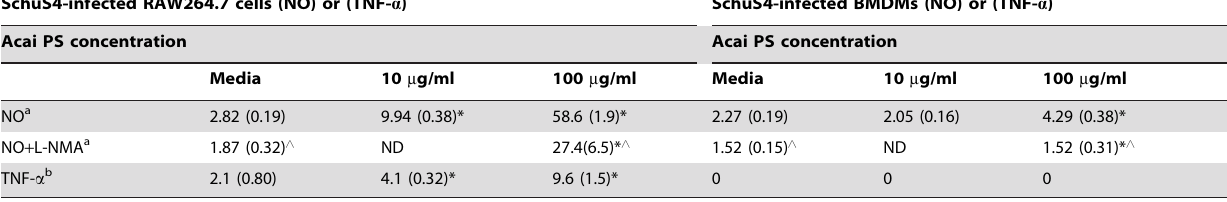
SchuS4-infected RAW264.7 cells (NO) or (TNF- a ) SchuS4-infected BMDMs (NO) or (TNF- a )